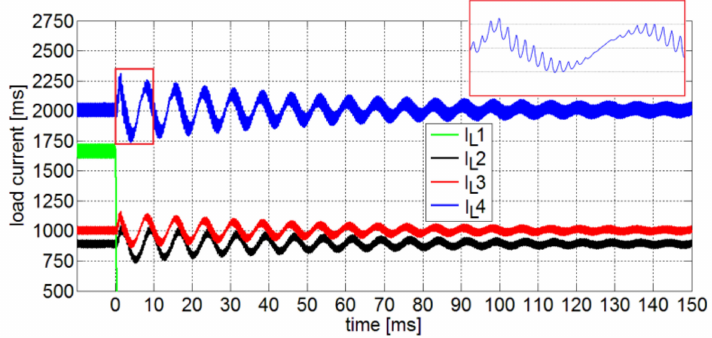
Figure 14. Load currents transient in Case 3 (each Y-division is 250 A in zoomed